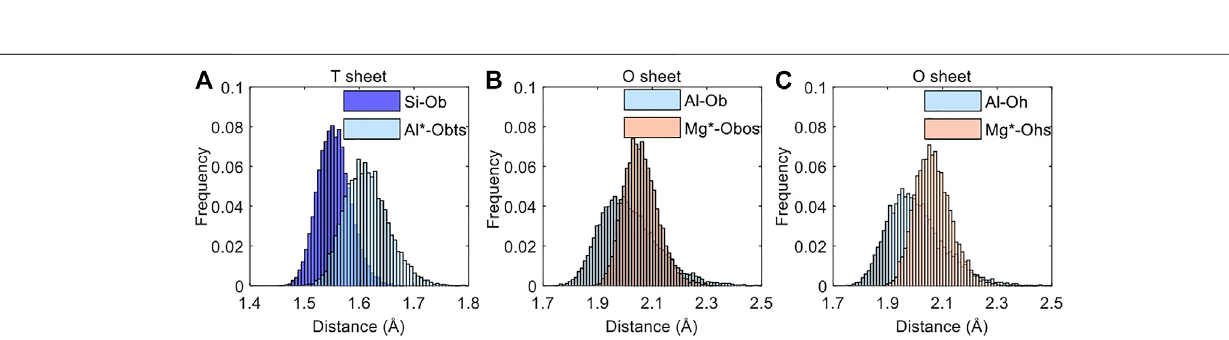
FIGURE 2 | The in-line compressional elastic constants C 11 , C 22 , and C 12 as a function of layer charge density for the (A) M1 Model, (B) M2 Model and (C) M3 Model.